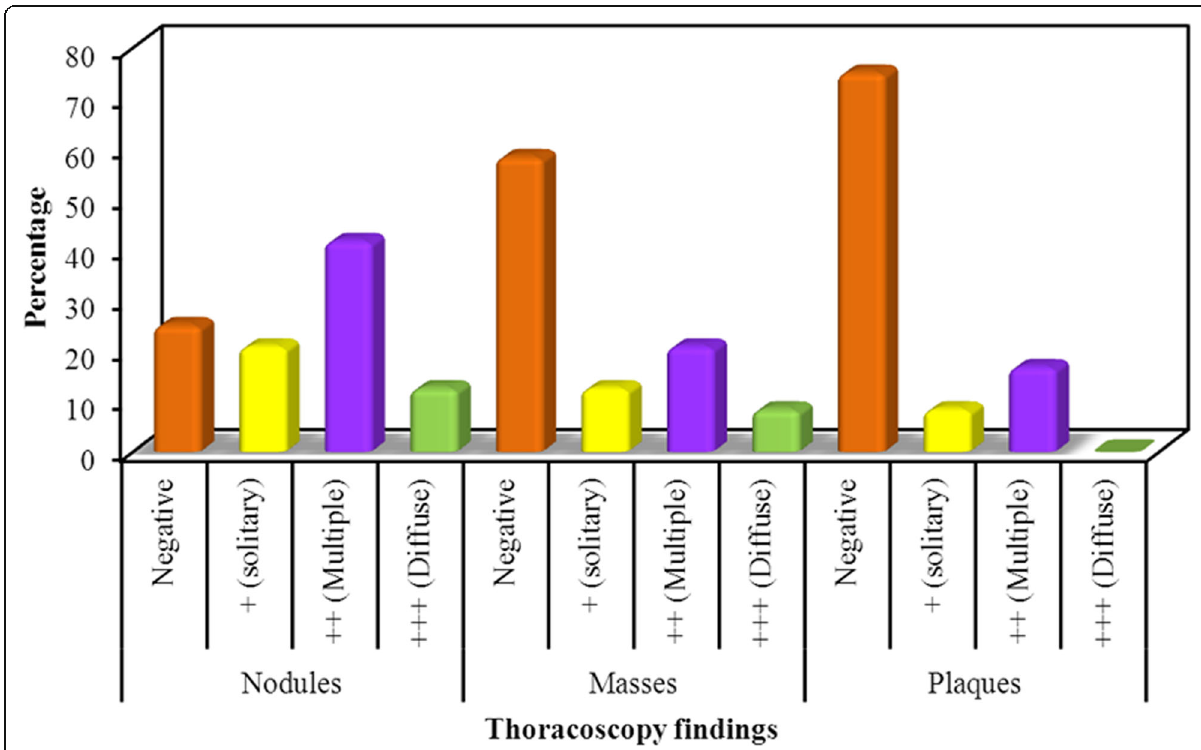
Fig. 2 Distribution of the studied cases according thoracoscopy findings ( n = 24)